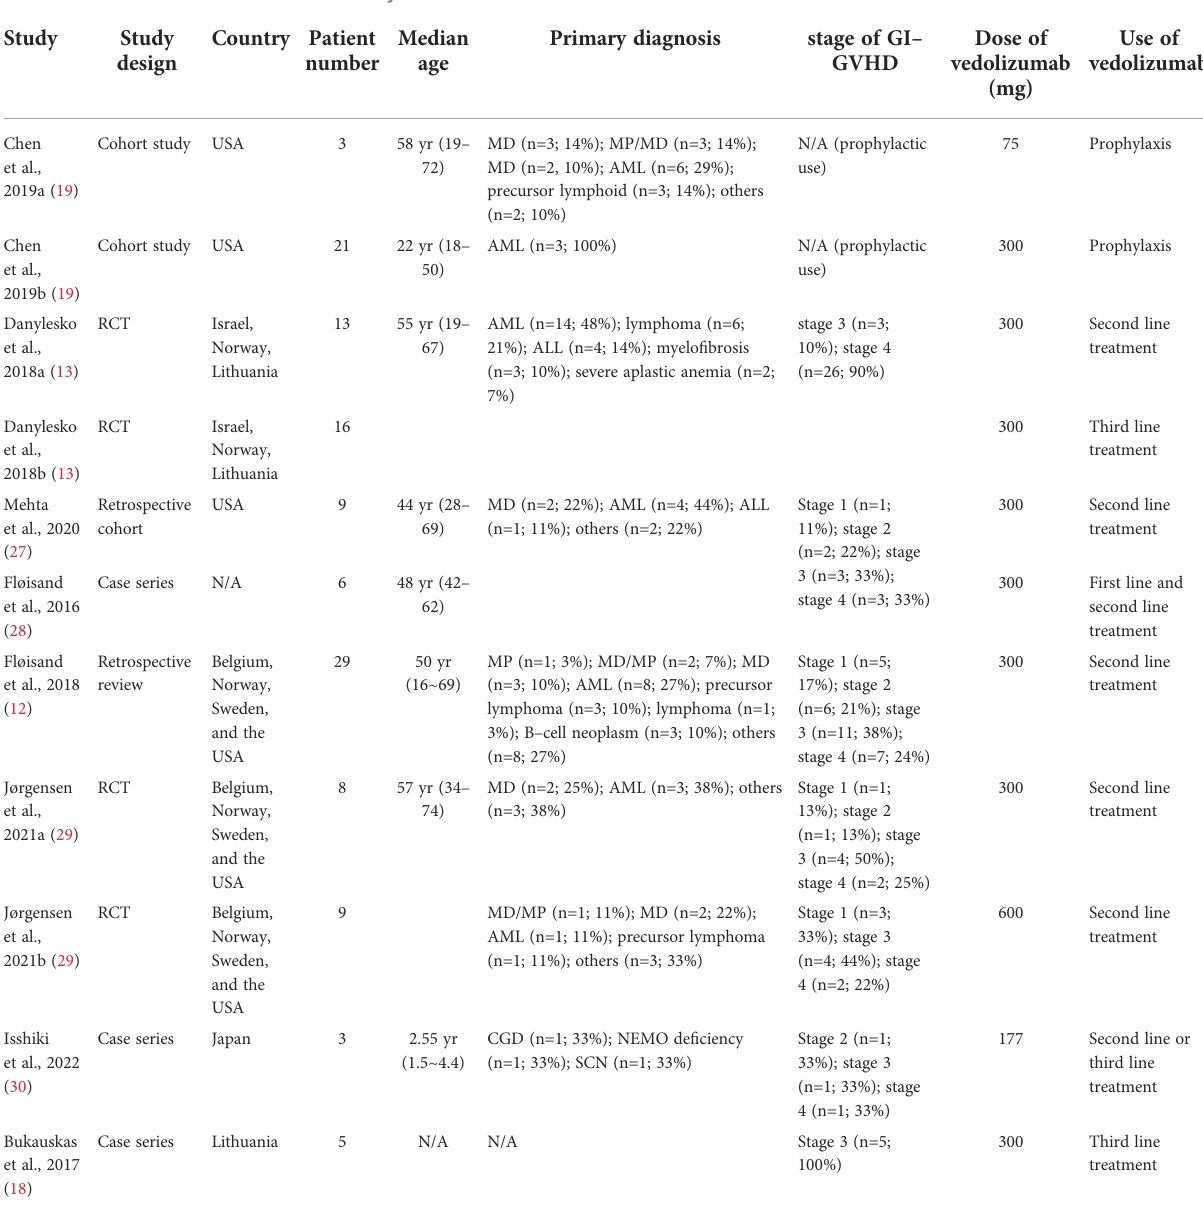
TABLE 1 Overview of studies included in the systemic